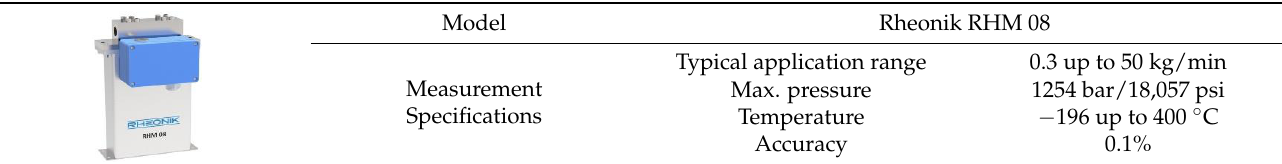
Table 7. Mass flow meter specification.